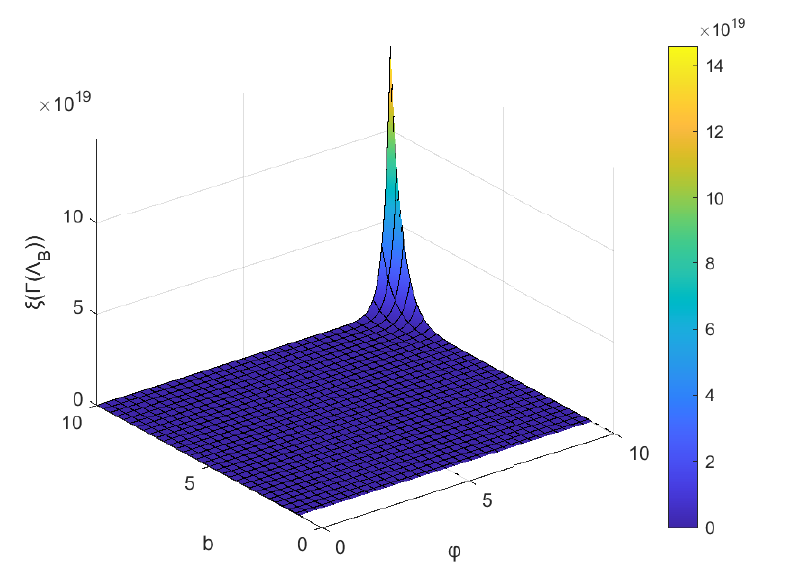
Figure 4. Eccentricity index of Γ ( Λ (cid:66) ) .